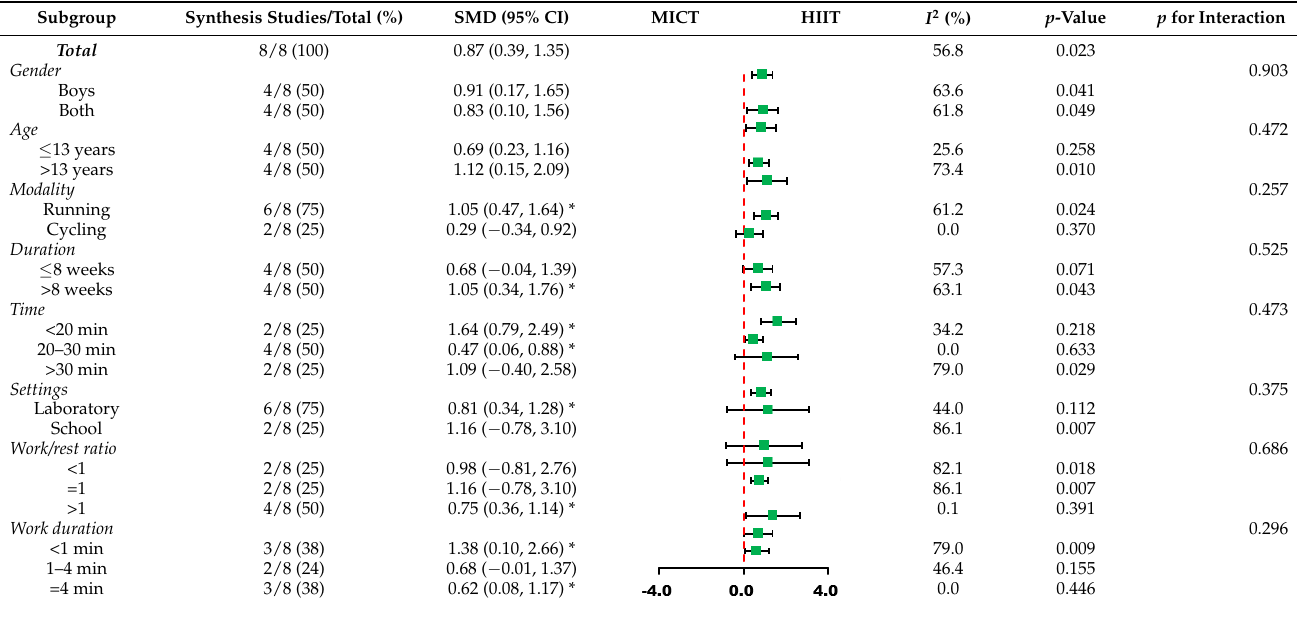
Table 3. Subgroup analysis of effects of HIIT vs. MICT on cardiorespiratory fitness.